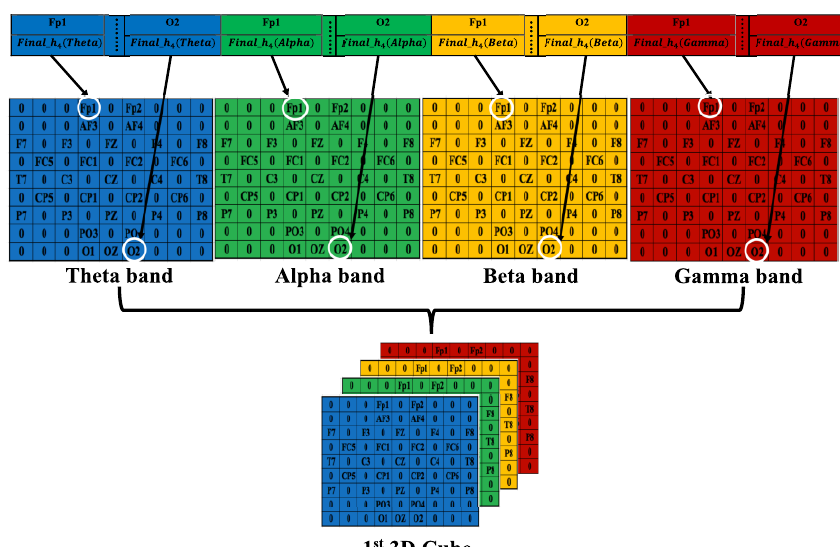
Figure 7. Illustration of the feature representation for each 32 channels in the DEAP dataset using a 3D Cube [3, 4, 38]